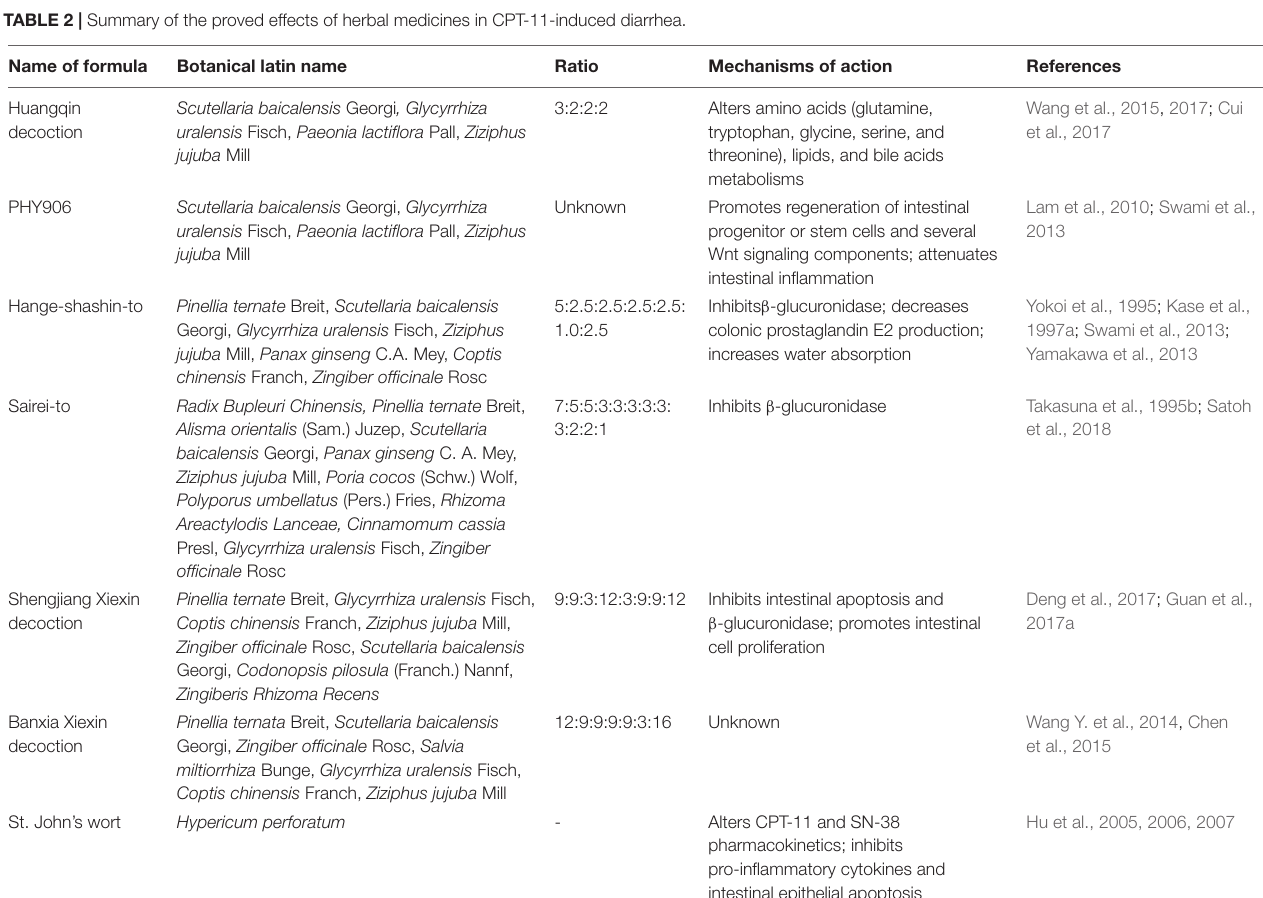
TABLE 2 | Summary of the proved effects of herbal medicines in CPT-11-induced